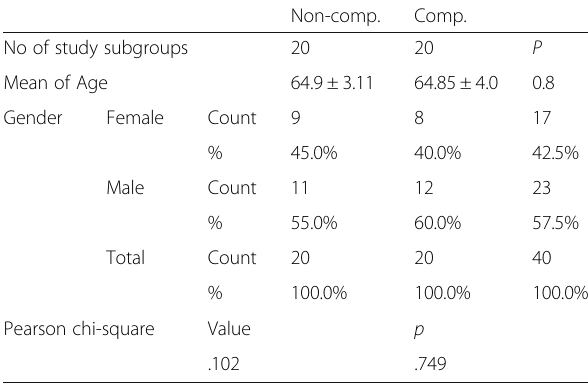
Table 5 The demographic data of the participants (40 subjects) in stage 3